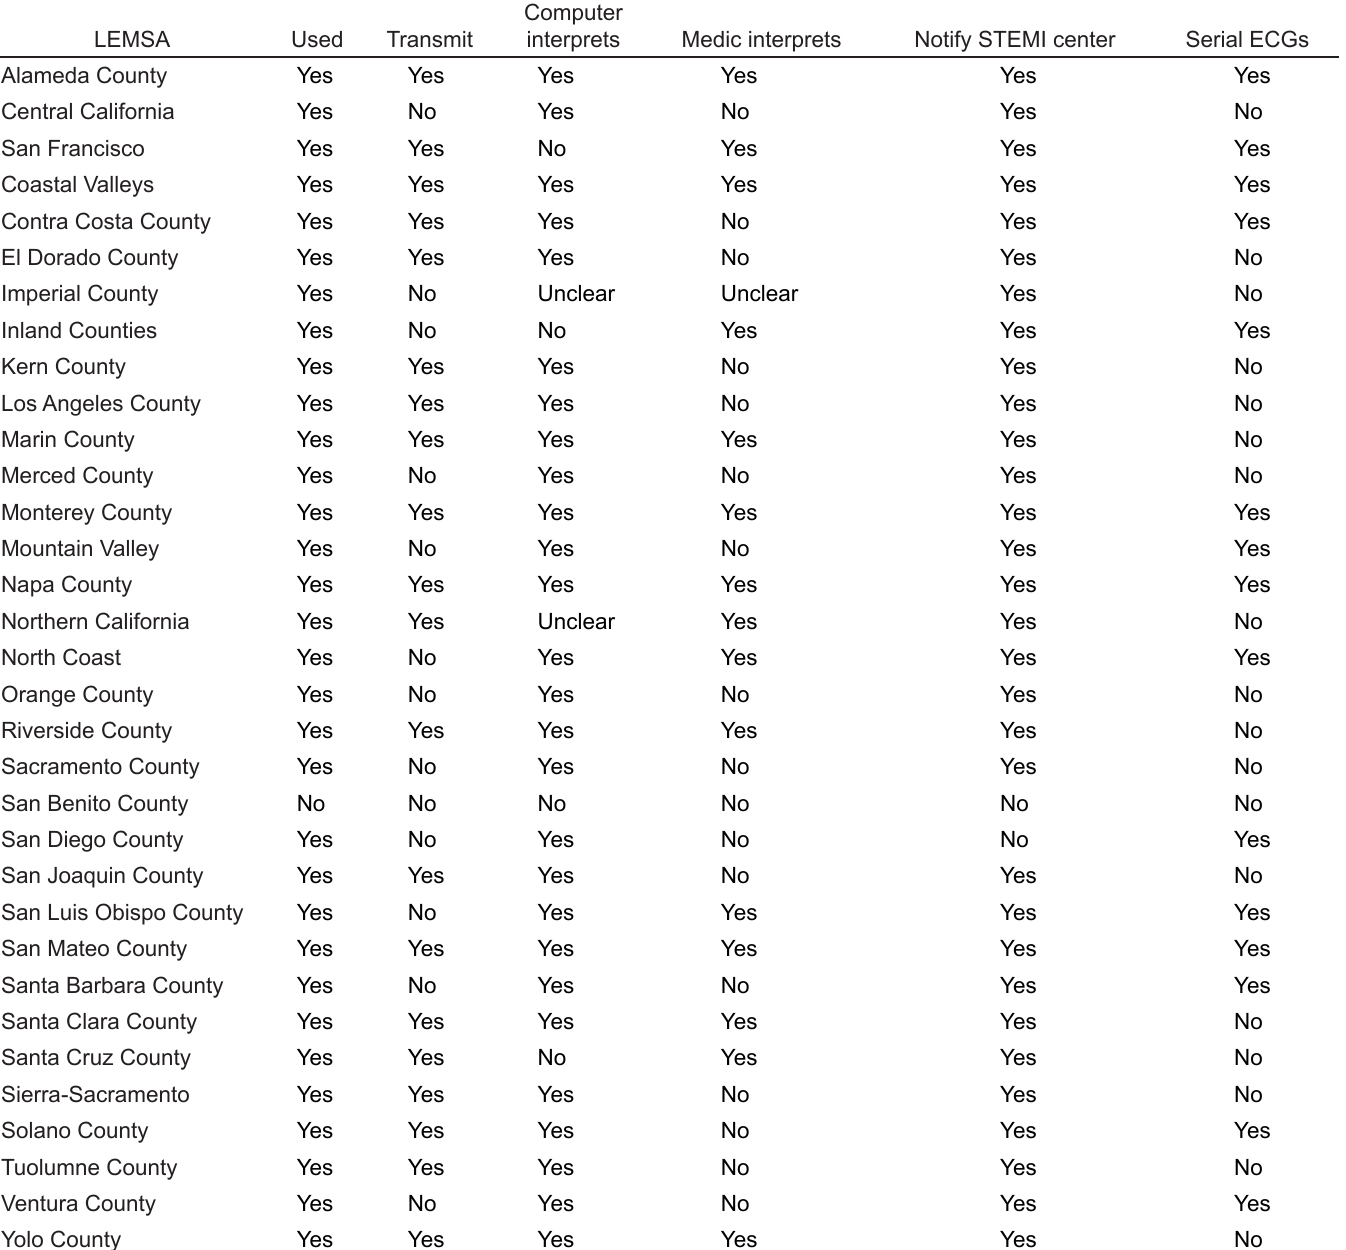
Table 5. 12-lead ECG in patients with chest pain. Computer LEMSA Used Transmit interprets Medic interprets Notify STEMI center Serial ECGs